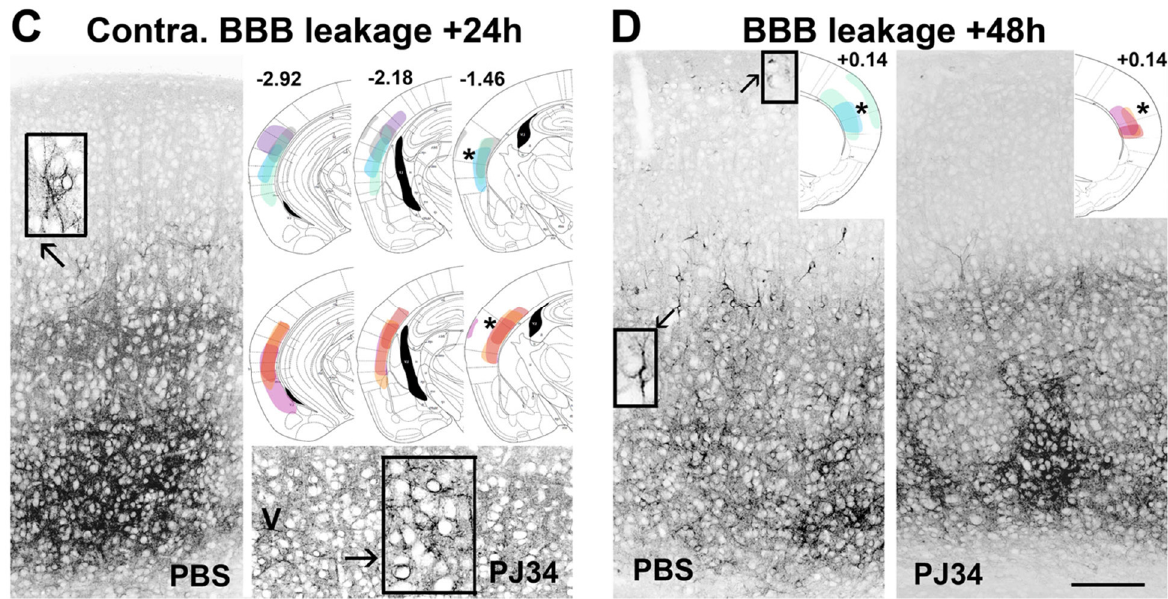
Figure 2. Blood-brain barrier permeability extent in PBS- and PJ34-treated mice following pMCAo. ( A,B ): Cartographies at 24 h (bregma − 2.92, − 2.18, − 1.46, − 0.70 and +0.14 mm) of the lesioned areas (doted lines) and regions of SST2 internalization (colorization, one color/animal), and illustrations of SST2 internalization (*star for captions) in PBS- ( n = 4) and PJ34-treated ( n = 3) mice. ( A ): At − 2.18 mm, SST2 internalization is detected in all cortical layers. Inserted boxes show high magnifications of cells displaying an SST2 labeling concentrated in the somatic (trans-Golgi network) compartment. Alongside, at +0.14 mm, only a few SST2 + -cells were located in the deep layers V–VI. ( B ): At − 2.18 mm in PJ34-, the distribution of SST2 + cells in all cortical layers is similar to that observed in PBS-treated mice. At +0.14 mm, SST2 internalization is mainly detected in deep layers V–VI with a few cells in layer I. ( C ): In both PBS- and PJ34-treated mice, SST2 internalization (upper layer V) is only detected at bregma − 2.92 to − 1.46 mm, contralateral to the lesion. ( D ): At 48 h after pMCAo and at the rostral level +0.14 mm, SST2 internalization is observed in almost all cortical layers in PBS-treated mice ( n = 3), whereas only deep layers V–VI contain SST2 + -cells in PJ34-treated mice ( n = 4). Black star indicates the absence of SST2 labeling. Scale bar represents 125 µ m and 30 µ m for the inserted captions,